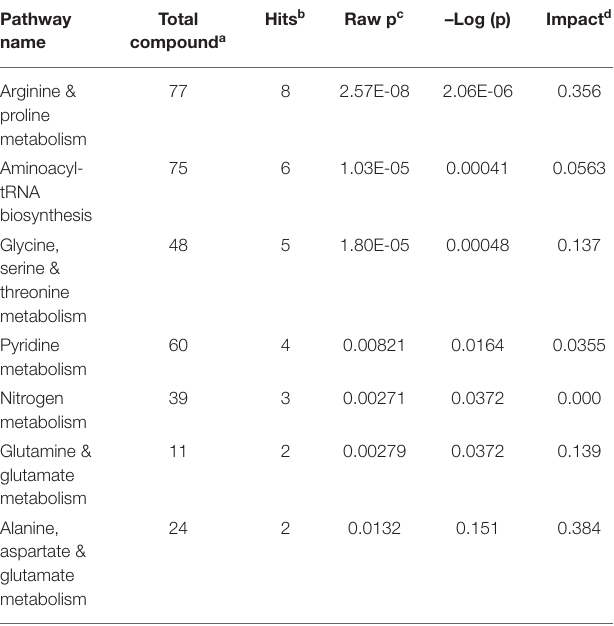
TABLE 2 | Description of the total number of compounds in the